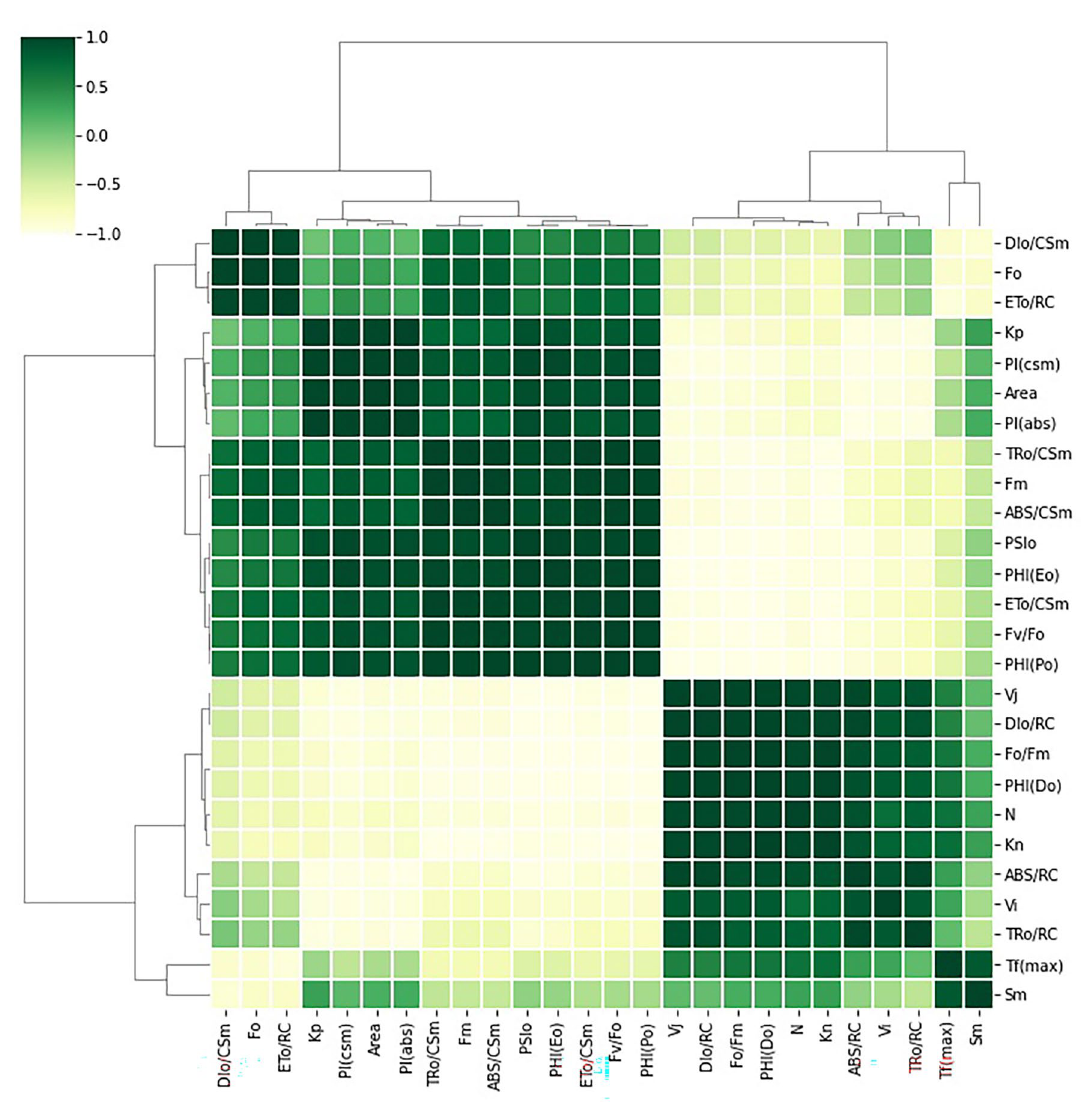
Figure 7. Grid correlation matrix shows the correlation between all calculated chlorophyll a fluorescence parameter with color